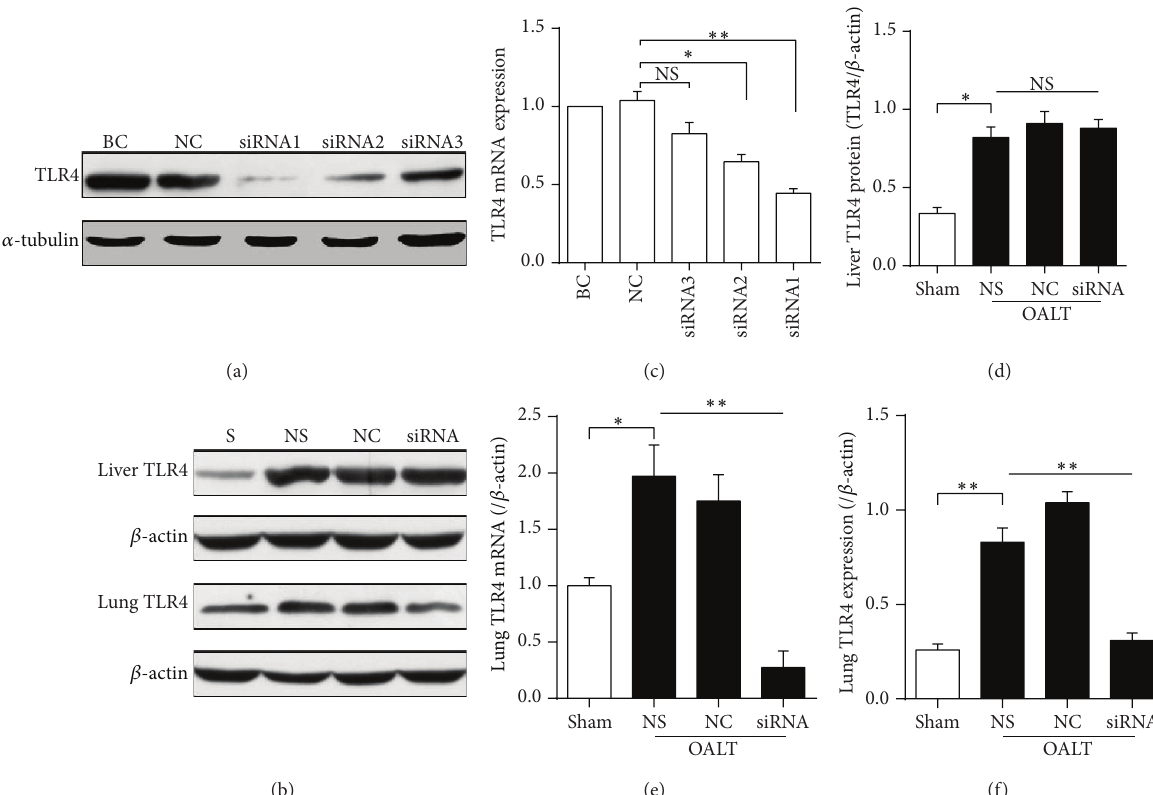
Figure 3: The effect of TLR4 siRNA on OALT-induced ALI in rats. (a) and (c) TLR4 gene and protein expression during screening for siRNAs. Groups BC, NC, siRNA1, siRNA2, and siRNA3 in A were treated with vehicle, negative control siRNA, siRNA1, siRNA2, and siRNA3, respectively. (b) and (d) showed the effects of TLR4 siRNA on TLR4 protein expression in liver tissue. (b), (e), and (f) showed the effects of TLR4 siRNA on TLR4 mRNA and protein expression in lung tissue. Groups S, NS, NC, and siRNA in (b) to (d) were treated with nothing, saline, negative control siRNA, and targeting siRNA, respectively. Values were expressed as mean ± SEM. NS: no statistical significance; ∗ 𝑃 < 0.05 , ∗∗ 𝑃 < 0.01 , one-way ANOVA with Tukey